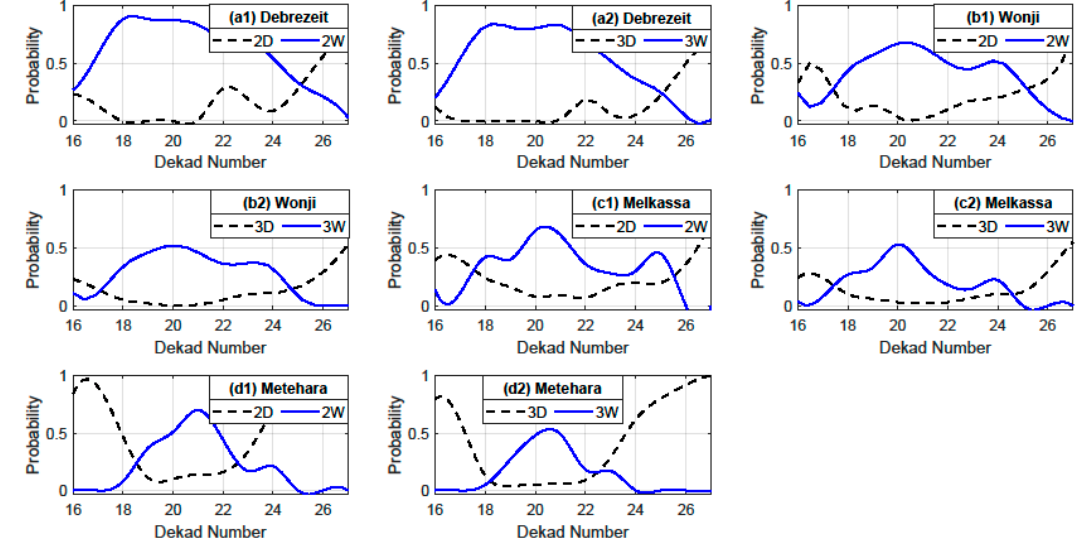
Figure 6. Probability of consecutive dry and wet dekads (2 D , 2 W , 3 D , and 3 W ) in the Kiremt season.